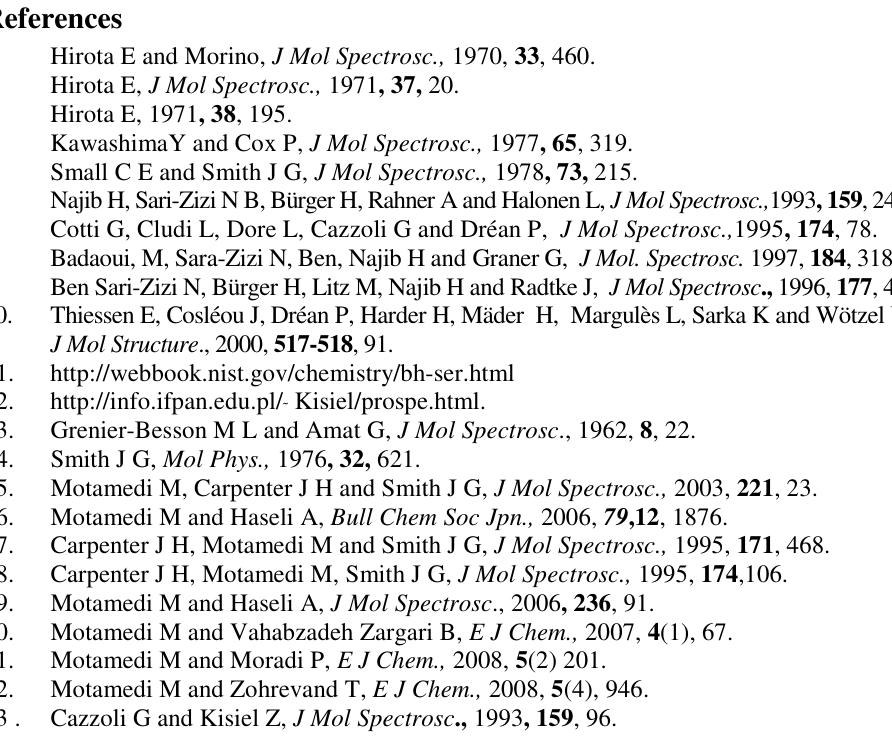
Table 8. Comparison of rotation-vibration parameters for PF